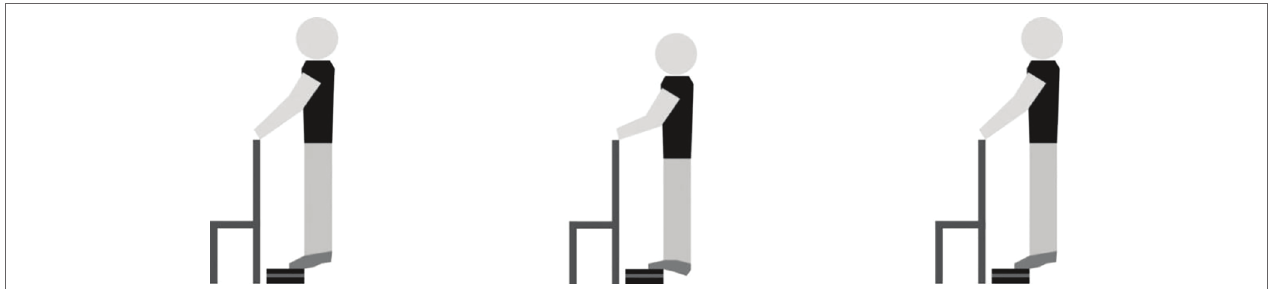
FIGURE 1 | Schematic representation of the ankle muscle fatigue